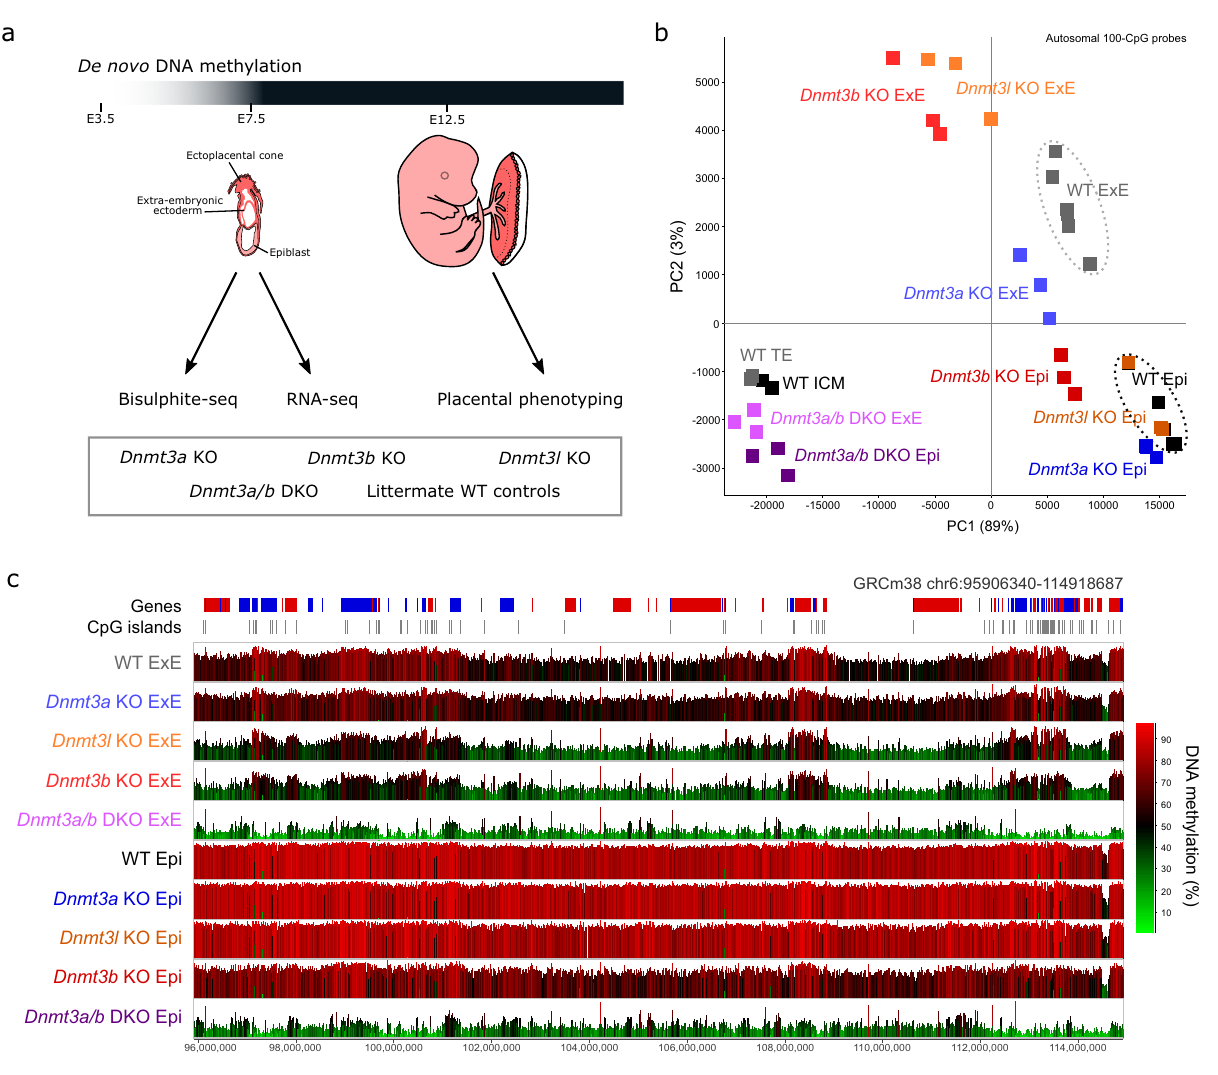
Fig. 1 | DNMT3A, 3B and 3L mediate de novo methylation in trophoblast cells. a The schematic diagramsummarises the study design. Embryos were collected at E7.5,afterthewindowofdenovoDNAmethylation,from Dnmt3a,Dnmt3b , Dnmt3l , Dnmt3a/b DKO and wildtype (WT) controls for bisulphite- and RNA-seq. Pheno- typing analysis was done on E12.5 placentas, when all placenta structures and cell types are present. The E12.5 embryo drawings are adapted from Perez-Garcia, V. etal .Placentationdefectsarehighlyprevalentinembryoniclethalmousemutants. Nature 555,463-468(2018). b Theprinciplecomponentplotshowsthedistribution